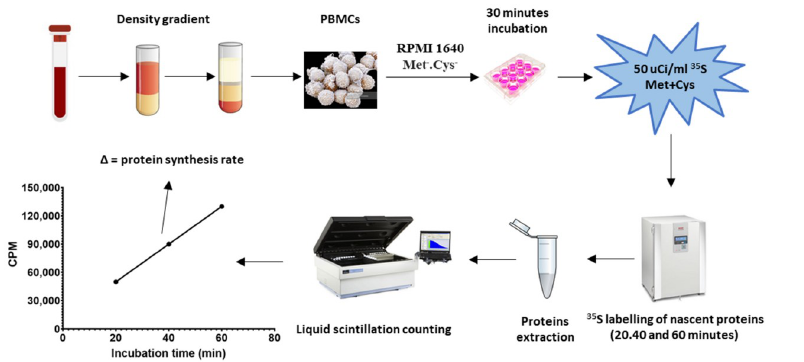
Fig 1. Schematic representation of the rate of protein synthesis